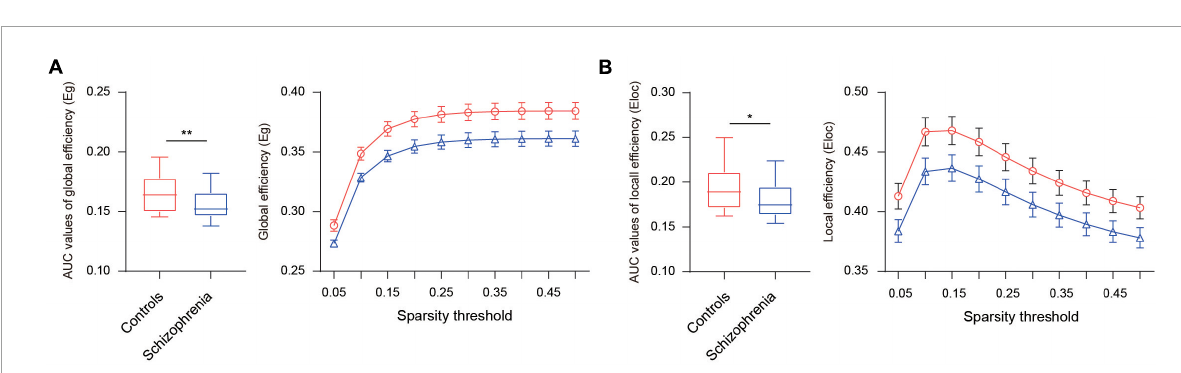
global processing length, and lower small-worldness during performing auditory oddball task when compared to the healthy control (29), suggesting that information interactions in the normal brains are more efficient at both local and global scales